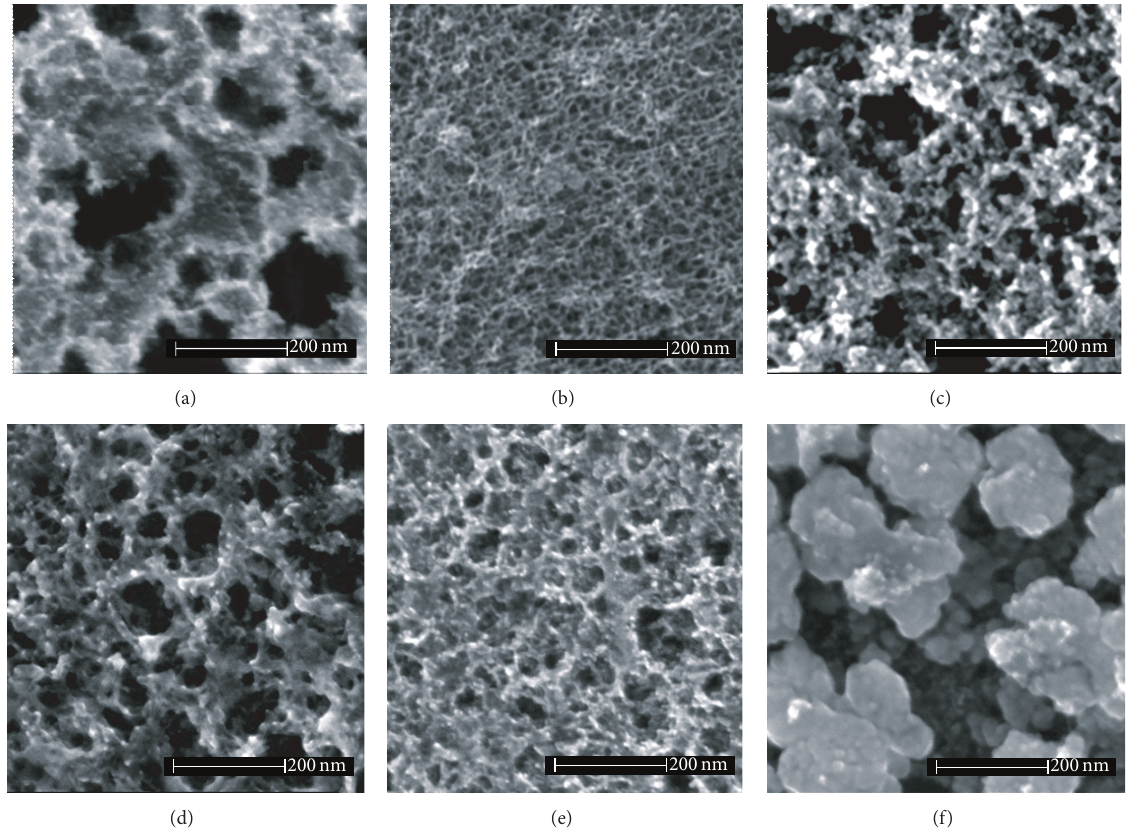
Figure 3: SEM images of the as-obtained NPMs (NPM 1#: (a), NPM 2#: (b), and NPM 3#: (c)) and the NPMs subjected to 1000 potential cycles in 0.1M KOH solution containing 50 mM glucose (NPM 1#: (d), NPM 2#: (e), and NPM 3#: